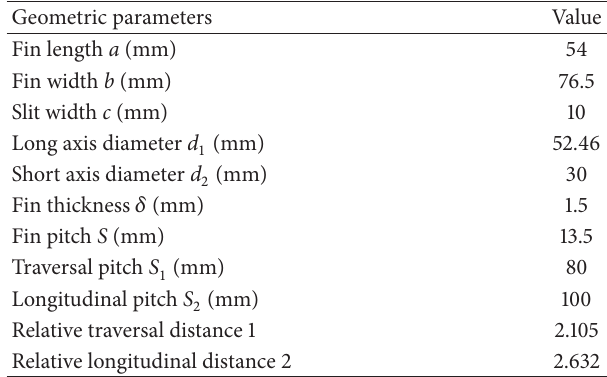
Table 2: Geometric parameters of finned tube bundles of experi- ment